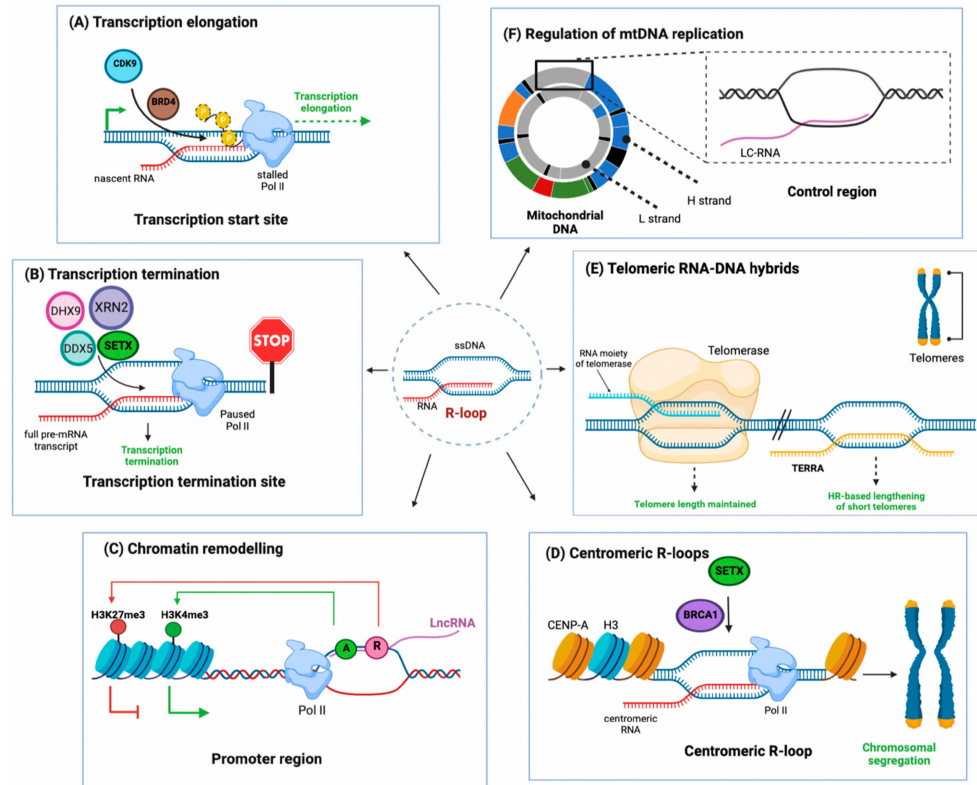
Figure 1. Physiological RNA-DNA hybrids serve important regulatory functions. RNA:DNA hybrids formed by a double-stranded RNA-DNA and a displaced single-stranded DNA are termed R-loops (Center). R-loops are important for several physiological cellular processes; ( A ) R-loops preferentially form at promoter sequences. Bromodomain containing protein 4 (BRD4) prevents the persistence of these R-loops by recruiting Kinases such as cyclin-dependent kinase 9 (CDK9), which phosphorylates the C-terminal domain of RNA polymerase II (Pol II), causing its transition from transcription initiation to transcription elongation. This alleviates Pol II stalling, which is a main cause for R- loop formation [1]; ( B ) At transcription termination sites, R-loop formation causes stalling of RNA polymerase II, which enforces transcription termination. Stalled Pol II is then released from the transcription site by R-loop resolving enzymes such as 5 (cid:48) -3 (cid:48) exoribonuclease 2 (XRN2), DEAD-Box helicase 5 (DDX5), and 9 (DHX9) [1]; ( C ) R-loops can regulate gene expression: Anti-sense long non-coding RNAs (lncRNA) can reanneal to their promoter DNA. In certain loci, this will, in turn, promote activating histone modifications (A, green circle) or repressive histone modifications (R, red circle) by recruiting the corresponding enzymes. Histone modifications, in turn, enhance or repress gene expression [2,3]; ( D ) R-loops form at centromeres, where tandem repeats known as α -satellite repeats are coated with Centromeric protein A (CENP-A) and are actively transcribed by Pol II. Co-transcriptional R-loops are resolved by Senataxin (SETX), which is recruited to the R-loops by BRCA1, allowing efficient chromosomal segregation [1]; ( E ) R-loops form at telomeres through hybridization of the lncRNA TERRA (telomeric-repeat containing RNA). In critically short telomeres, this activates an alternative lengthening of telomeres through RAD51-dependent homology-directed repair (HR) [1,4]; ( F ) Mitochondria contain R-loops in their DNA, where a regulatory R-loop forms at the control region of the mtDNA by the annealing of L-strand transcripts to the control region DNA (termed L-strand control RNA, LC-RNA). Mitochondria also form a triple-strand loop structure known as D-loop—in contrast to R-loops, the third strand in D-loops is 7S DNA. Mitochondrial R-loop and D-loop are important for regulation of mtDNA replication [8]. ssDNA: single-stranded DNA; L- strand: light strand; H-strand: heavy strand; LC-RNA: L-strand control RNA; CDK9 (kinase):